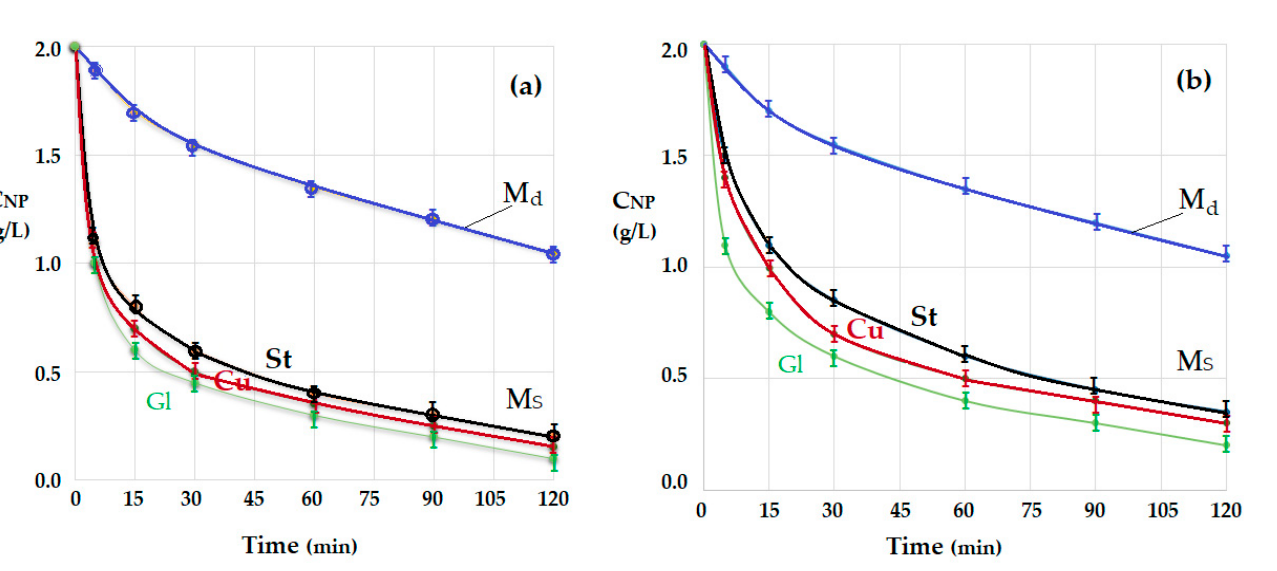
Figure 7. The decrease in concentration of p –nitrophenol for operation in the drip module (Md) and in the module with spheres (Ms) of the three types of materials: St, steel; Cu, copper; and Gl, glass; for source phase (SP) with pH = 2 and receiving phase (RP) with pH = 13. ( a ) n –octanol membrane; ( b ) n –decanol membrane.